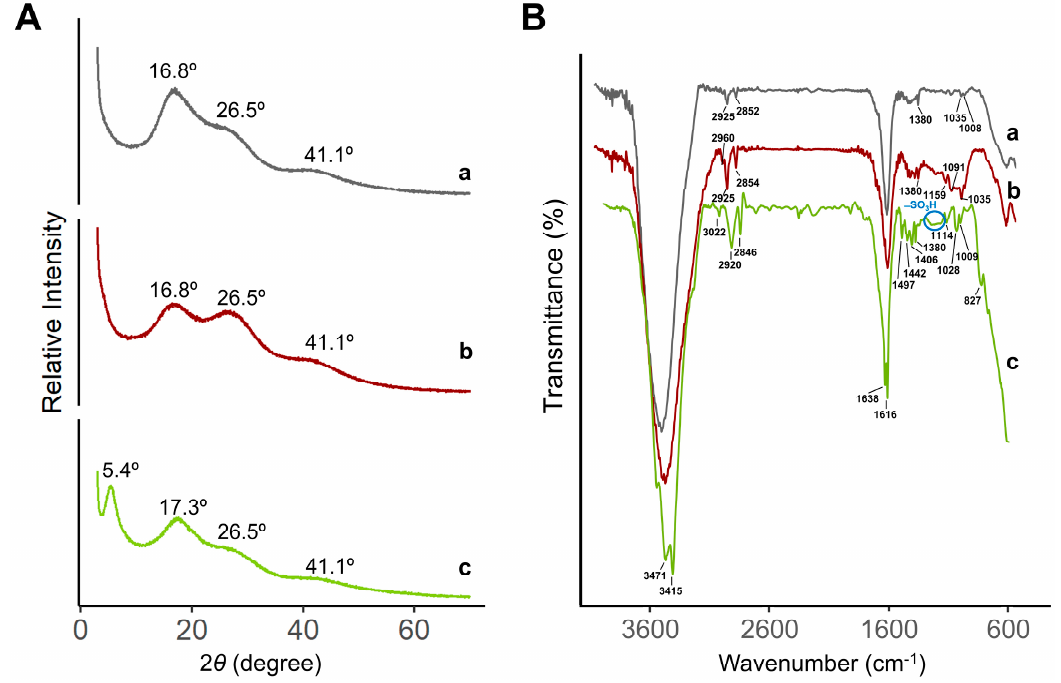
Figure 5. ( A ) XRD patterns and ( B ) FT-IR spectra of resins: ( a ) inactivated H-form, ( b ) activated H + -form, and ( c ) Na + -form.